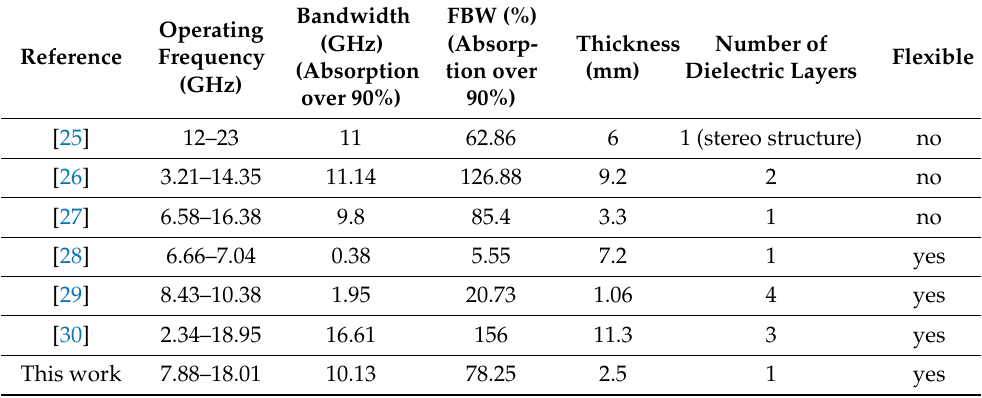
Table 1. Performance comparison of the proposed FBMPA with recently-reported MPAs by using conductive ink.